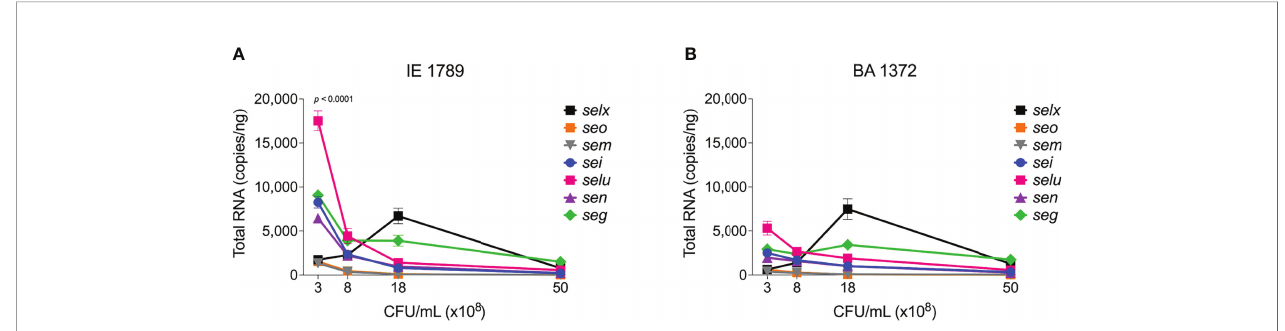
FIGURE 7 | Differential expression of egc SAgs and selx . Quantitation of egc mRNA in S. aureus CC5 during growth in TH broth by RT-qPCR standard curve quantitation method. egc and selx expression in (A) IE1789 and (B) BA1372 at indicated cell densities. Error bars (standard deviation) not shown are smaller than symbol. Data is the result of three biological replicates. Two-way ANOVA with Holm-S ̌ ı ́ da ́ k ’ s multiple comparisons test across superantigen pairs in IE1789 and BA1372 during exponential